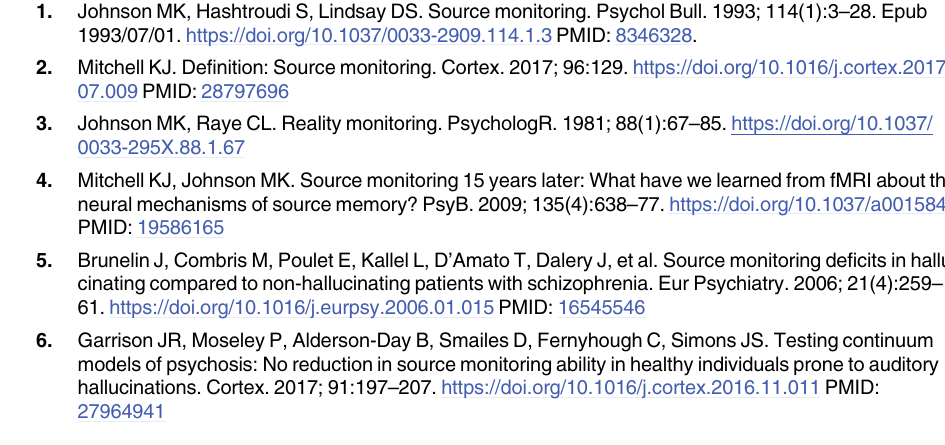
S1 Table. Reporting checklist for tDCS studies. Variant appropriate to our study marked with “X”. S2 Table. Frequency of adverse events during sham and real tDCS session in the offline experiment. S3 Table. Frequency of adverse events during sham and real tDCS session in the online